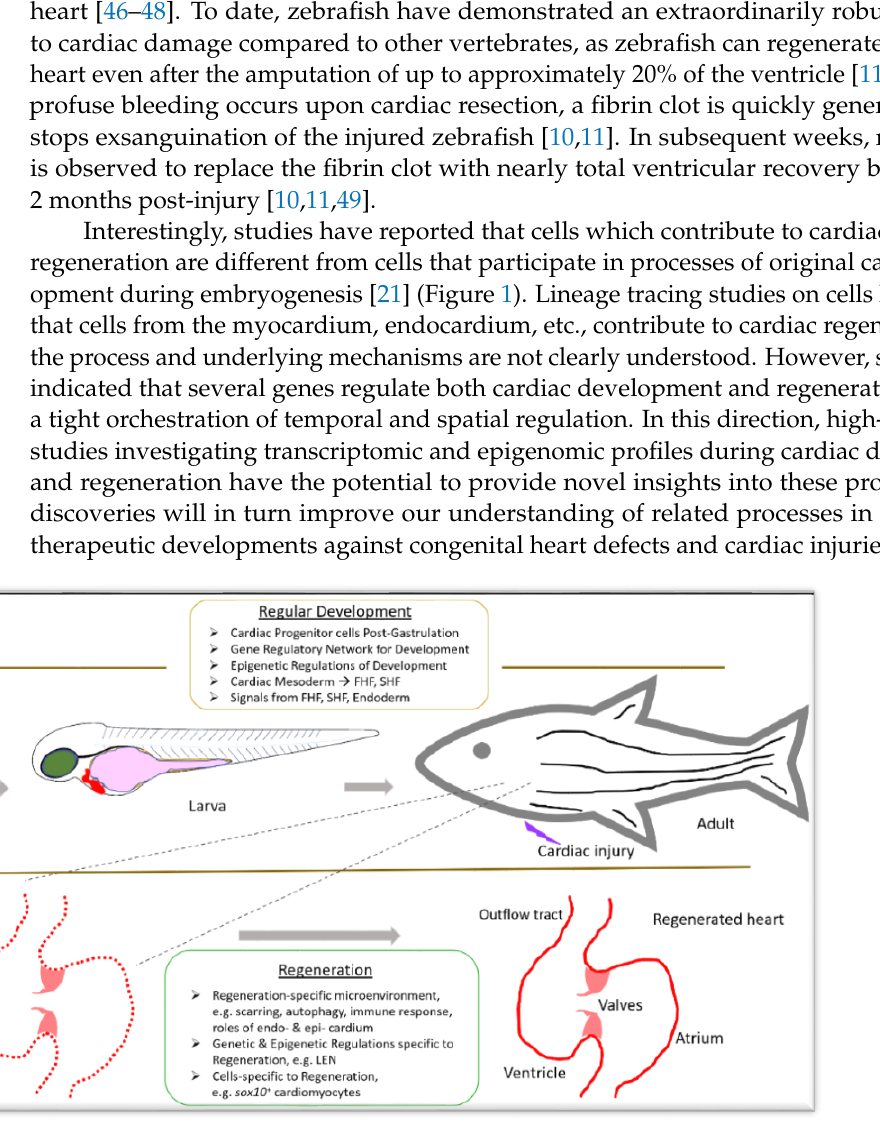
Figure 1. Overview of differences between cardiac development and regeneration in zebrafish. Upper and lower panels outline development and regeneration, respectively. Keys: FHF and SHF—1st and 2nd heart fields, LEN— lepb -linked enhancer, ➔— resulting in.